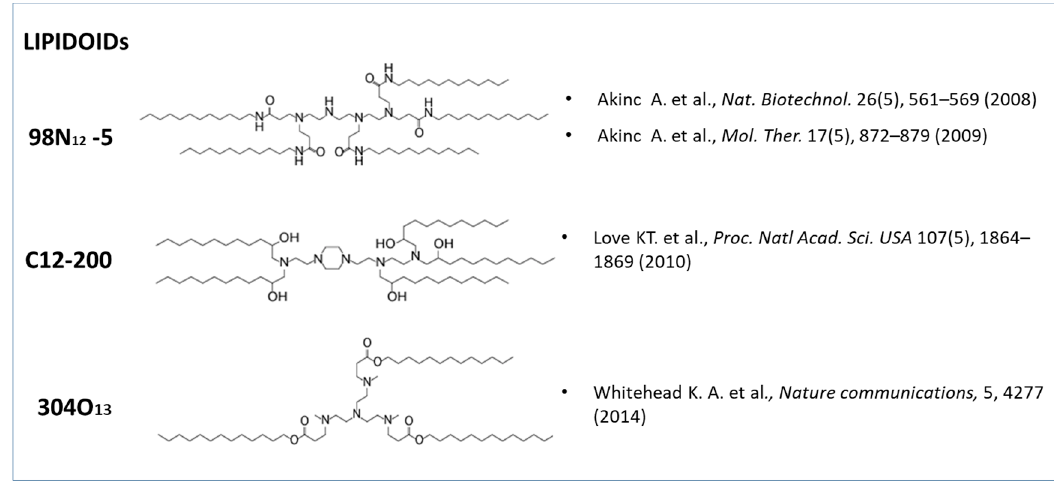
Figure 4. Lipidoids synthetized by different research groups and used in cationic liposomal formulations to increase siRNA encapsulation efficiency. to increase siRNA encapsulation e ffi